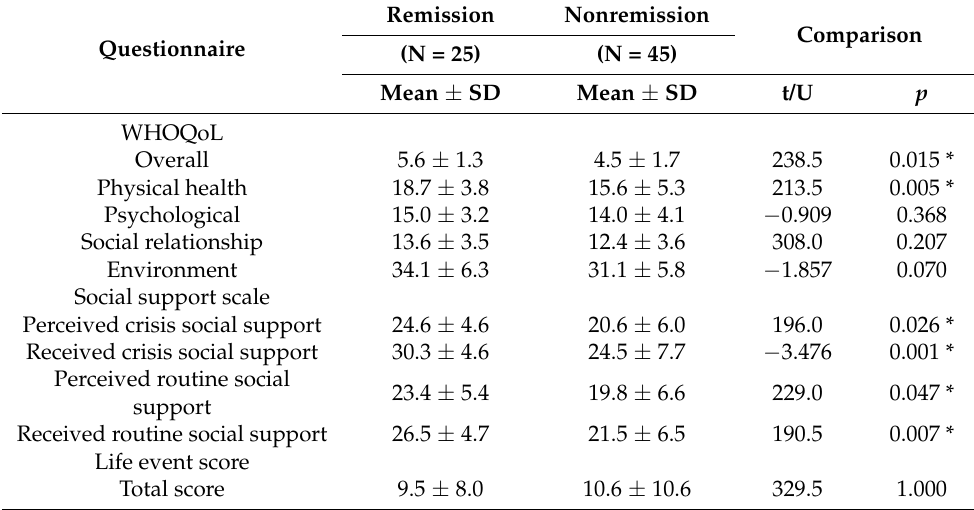
Table 2. Questionnaire scores of the remission and nonremission patients.